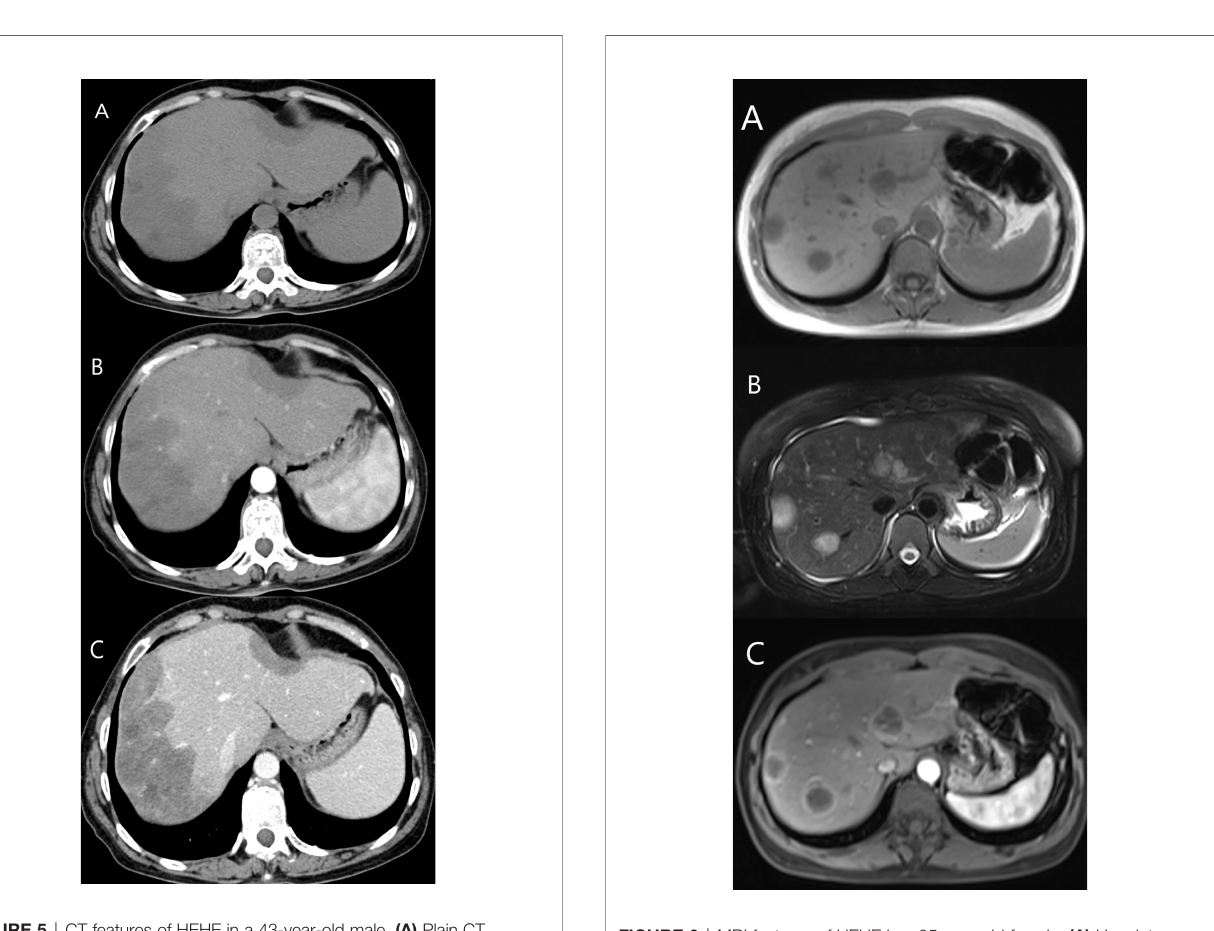
FIGURE 6 | MRI features of HEHE in a 35-year-old female. (A) Hypointense showed on T1-weighted image. (B) The lesions displayed hyperintense on T2-weighted image. (C) Rim-like enhancement and lollipop sign were seen after contrast agent